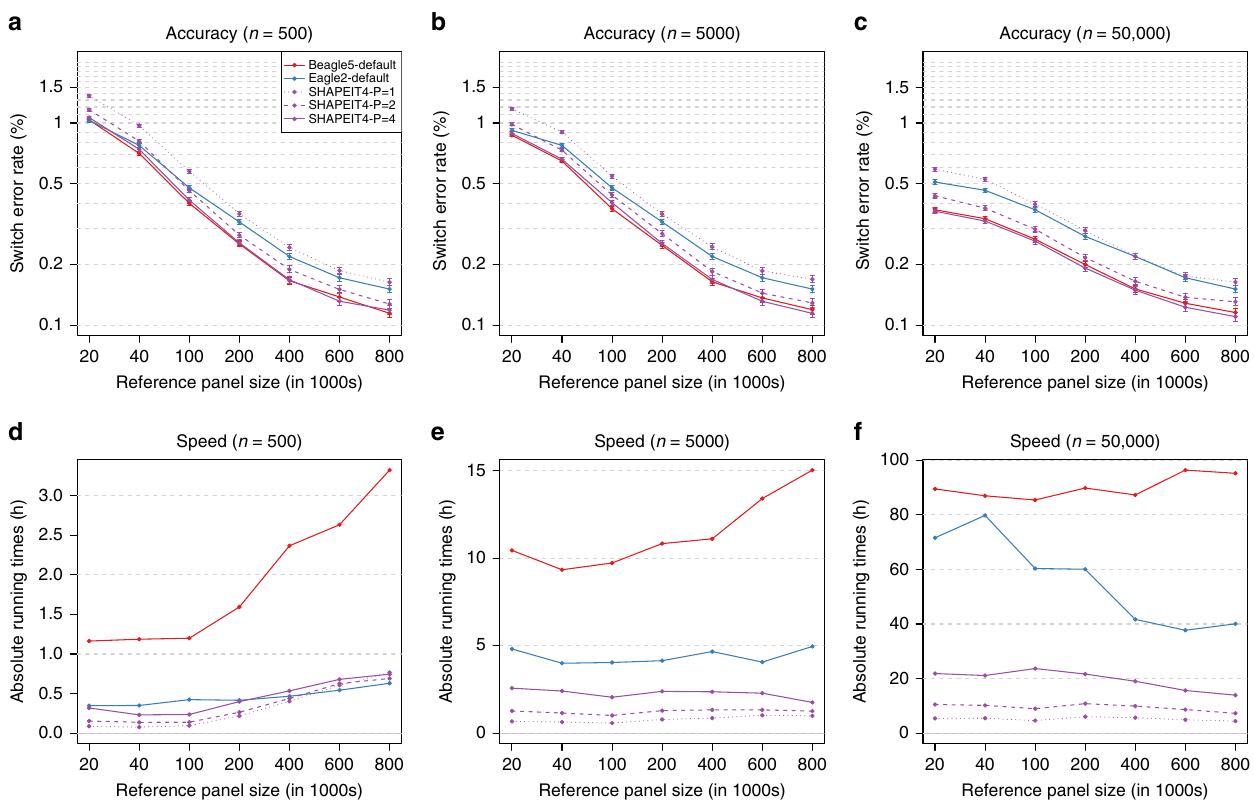
Fig. 3 Phasing performance from large reference panels (UKB). Switch error rates ( a – c ) and running times ( d – f ) for all tested phasing methods as a function of the number of haplotypes in the reference panels. Three different sample sizes were tested for the main panel: 500 ( a , d ), 5000 ( b , e ), and 50,000 ( c , f ). For each error rate is given the 95% binomial con fi dence interval. Source data are provided as a Source Data fi le.